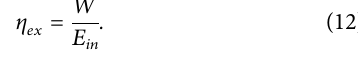
Frontiers in Energy Research |